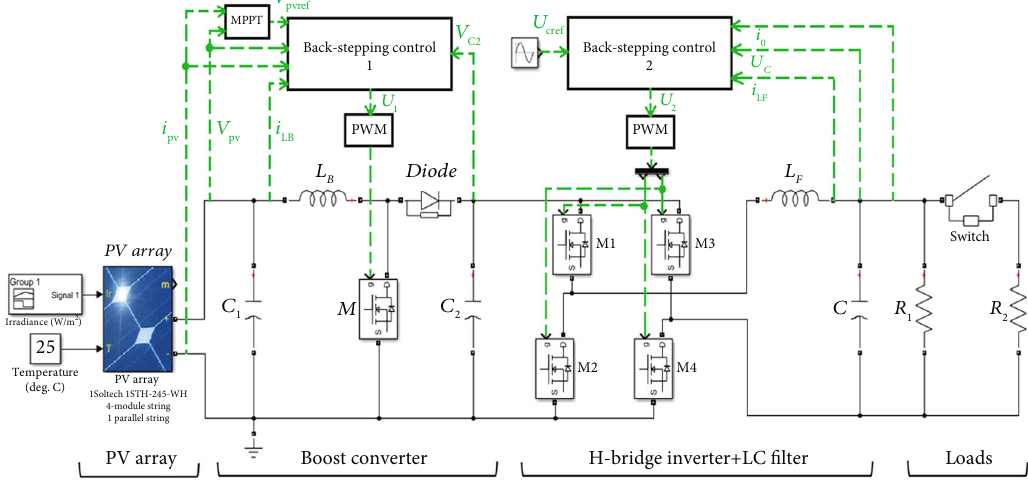
Figure 9: Schematic of the proposed PV inverter